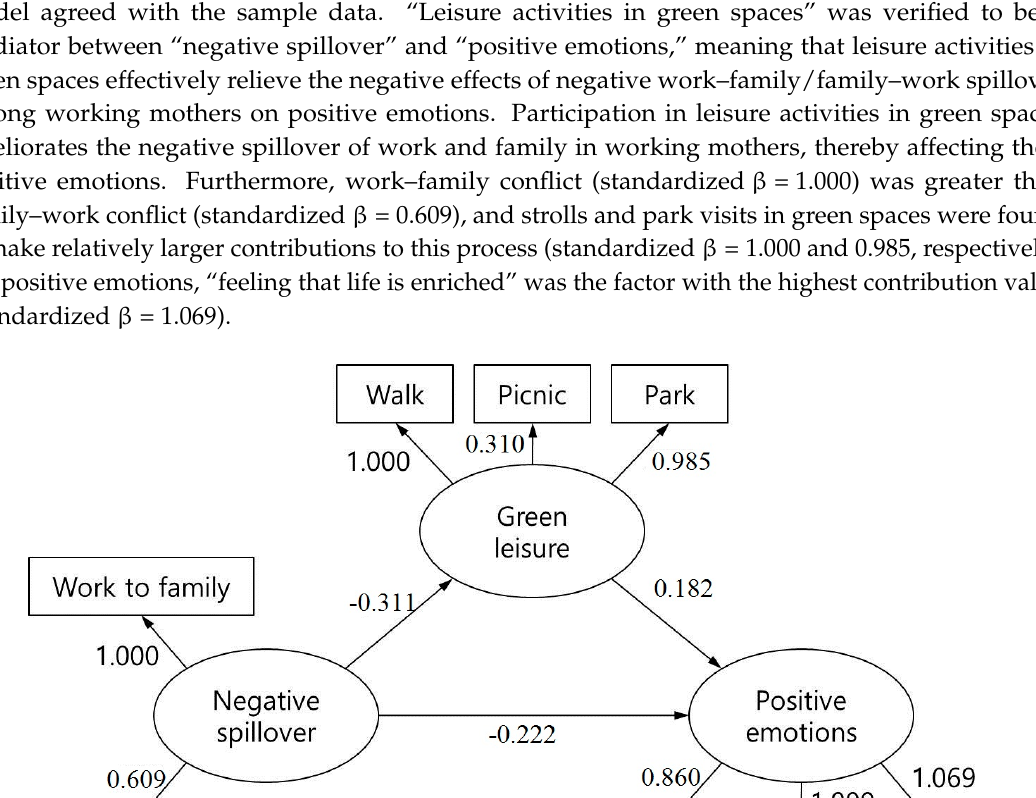
Table 3. Modified Path Model and Test of the Mediating